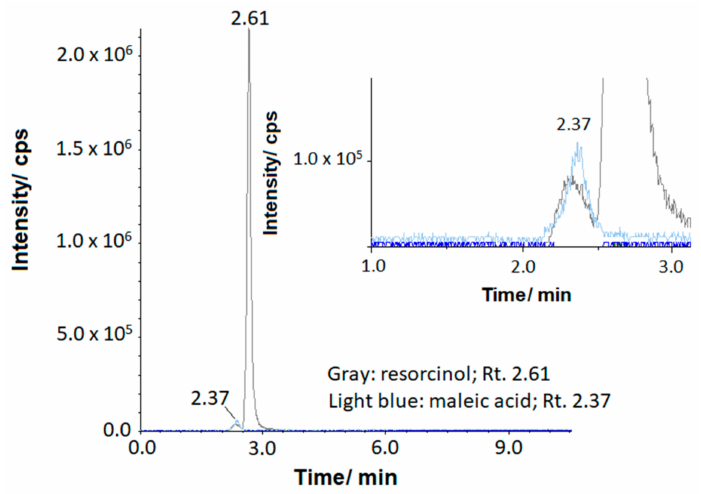
Figure 9. HPLC chromatograms recorded for resorcinol-based, electrolyzed synthetic (Na 2 SO 4 ) wastewater solution, exhibiting detected maleic acid intermediate